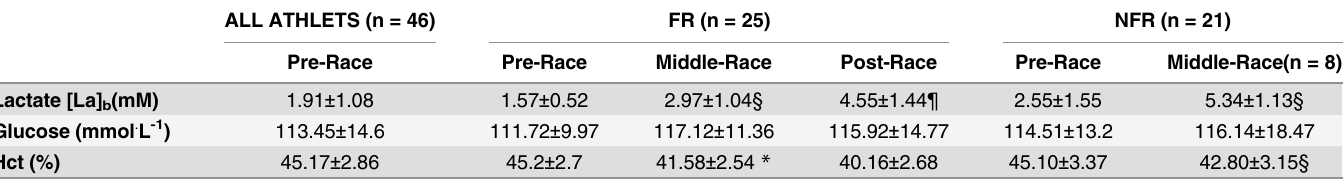
Table 2. Haematological